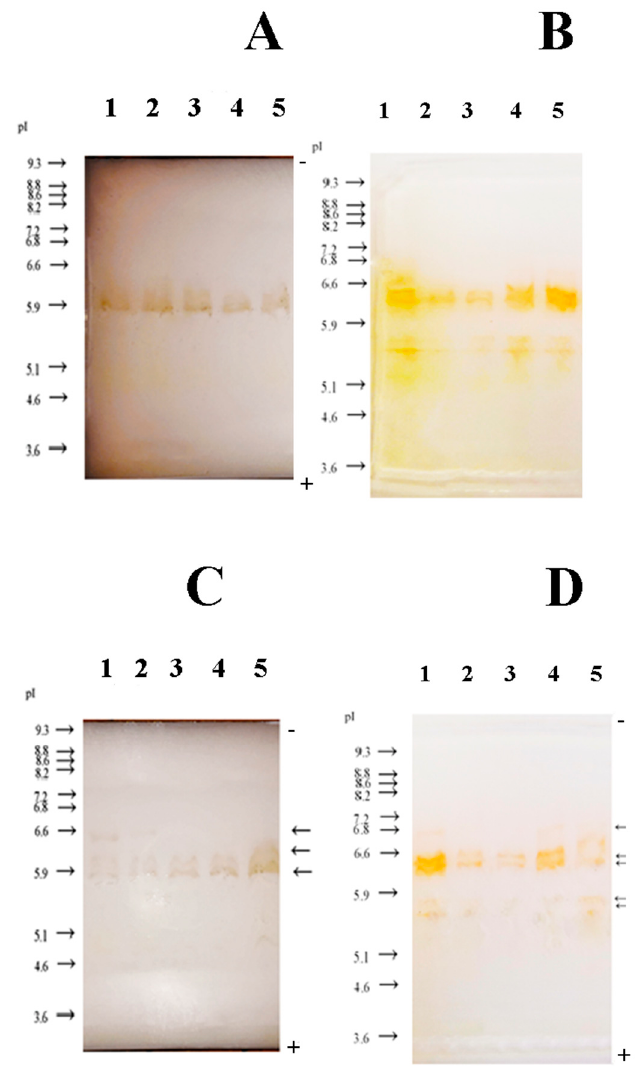
Figure 3. Zymogram detection of guaiacol peroxidase (GPX): ( A ) sterile duckweeds cultivated in phenol-free MS medium (control plants); ( B ) sterile duckweeds cultivated in phenol-supplemented MS medium; ( C ) duckweeds inoculated with bacteria H. paralvei and cultivated in phenol-free MS medium; ( D ) duckweeds inoculated with bacteria H. paralvei and cultivated in phenol-supplemented MS medium. Numbers (1–5) represent days of cultivation. Concentration of phenol in all experiments was 500 mg L − 1 . pI—isoelectric point.